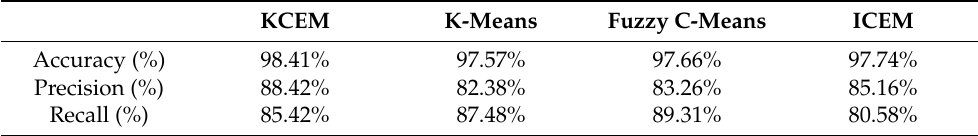
Table 9. Non-mass tumor: Confusion matrix.